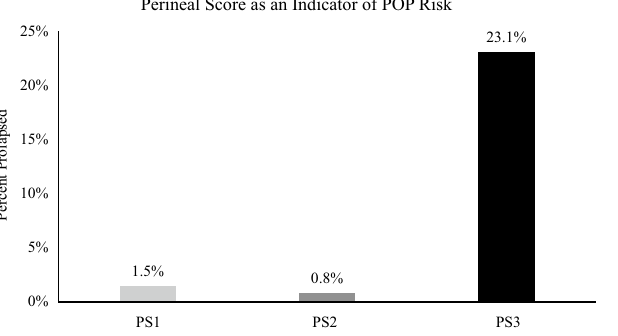
Figure 1. Perineal score in late gestation as an indicator of pelvic organ prolapse (POP) risk. Perineal scoring was conducted on sows (n = 213) during late gestation (days 105–117). Sows assigned a PS1 (n = 68), PS2 (n = 119) and PS3 (n = 26) were assumed low, medium or high risk, respectively, for POP. As predicted, 23.1% of PS3 scored sows subsequently died due to POP while 1.5 and 0.8% of sows scoring PS1 and PS2, died respectively. These data demonstrate the ability to distinguish differential risk of POP for animals during late